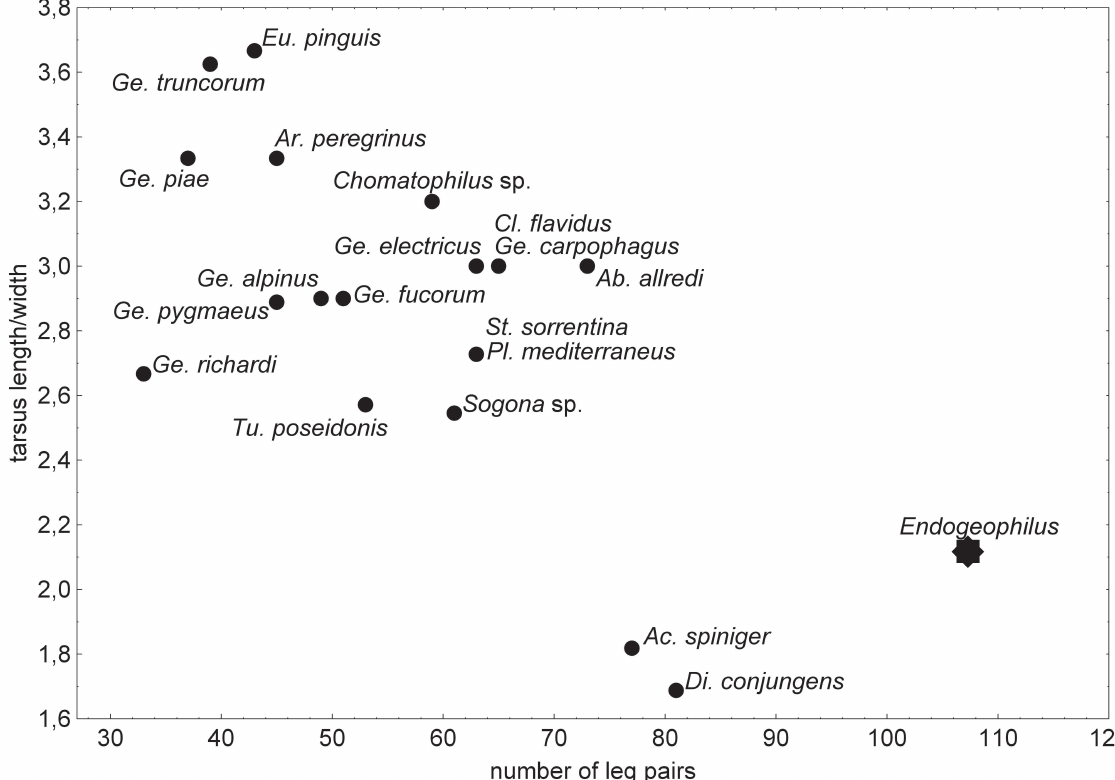
Fig. 7. Variation in the elongation of legs and the number of legs in a sample of species of Geophilidae, including Endogeophilus ichnusae gen. et sp. nov. The length/width ratio of a leg tarsus was measured at about 20% of the longitudinal series of legs. Full names of species in ‘Material and